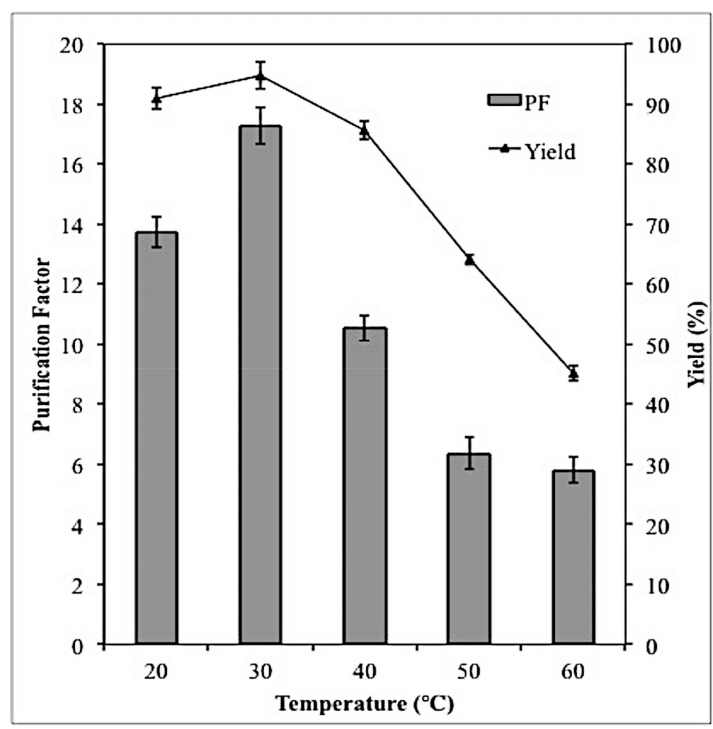
Figure 4. Effect of different temperatures on lipase partitioning in the top phase was investigated at 46.4% ( w / w ) TLL, 20% ( w / w ) crude load and pH 8. All the assays were conducted in triplicate and the average values were taken.